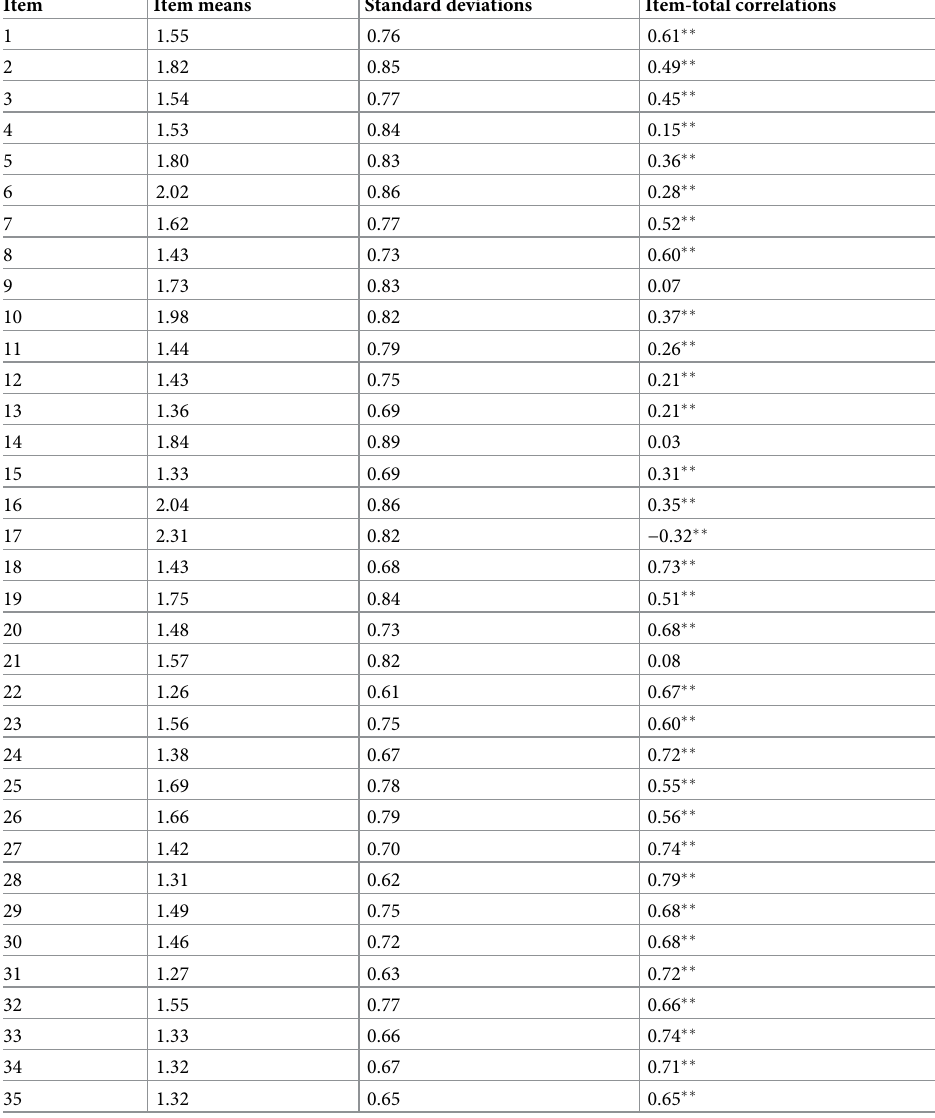
Table 4. Item means and item-total correlations of the